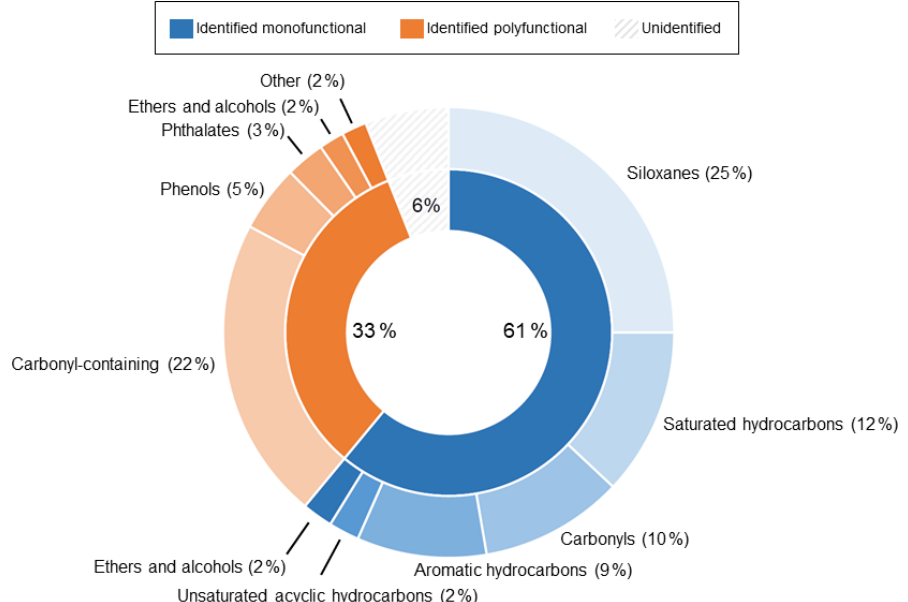
Figure 5. Pie chart summarizing the background composition of the LI-6800 with no leaf in the chamber, collected using the SAM port of the PPS. Percentages are provided to indicate the contribution of each class of compounds to the total integrated peak area. The inner pie chart shows the division of total ion counts for identified monofunctional (containing a single functional group), identified polyfunctional (containing multiple functional groups), and unidentified (grey stripes) peaks. Identification required an integrated peak area over 50000 counts and a NIST library match score of at least 500. The outer pie chart shows the subsequent breakdown of both identified